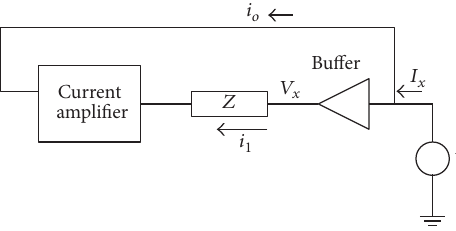
Figure 1: Block diagram of the proposed design.